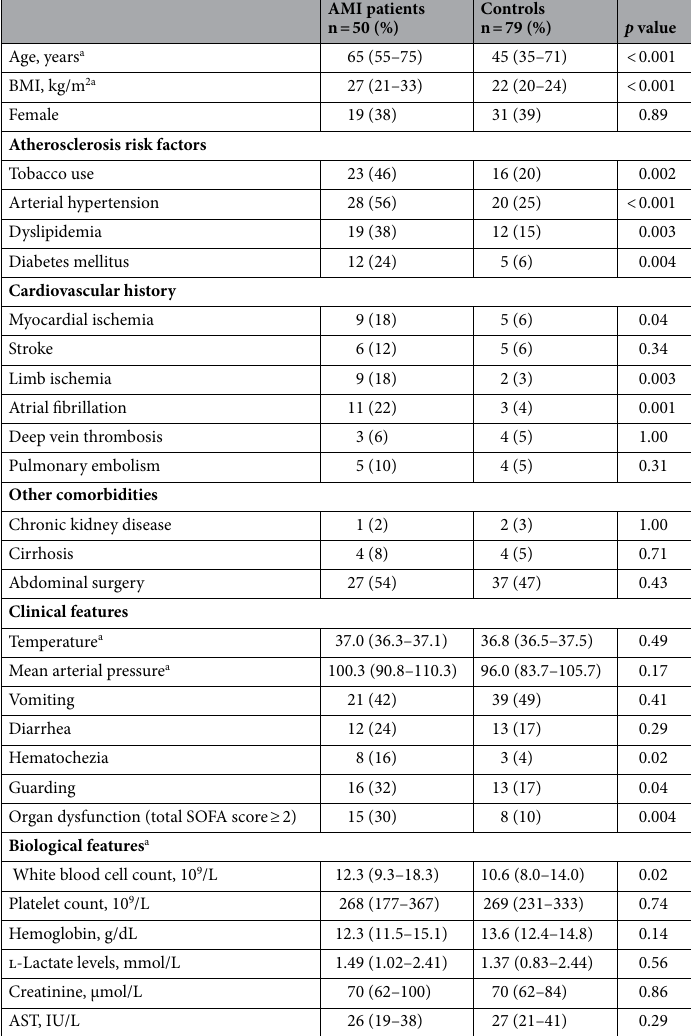
Table 1. Baseline characteristics of AMI patients and controls. Abbreviations: AMI acute mesenteric ischemia, BMI body mass index, SOFA sequential organ failure assessment, AST aspartate aminotransferase, IU international units. a Median (inter quartile